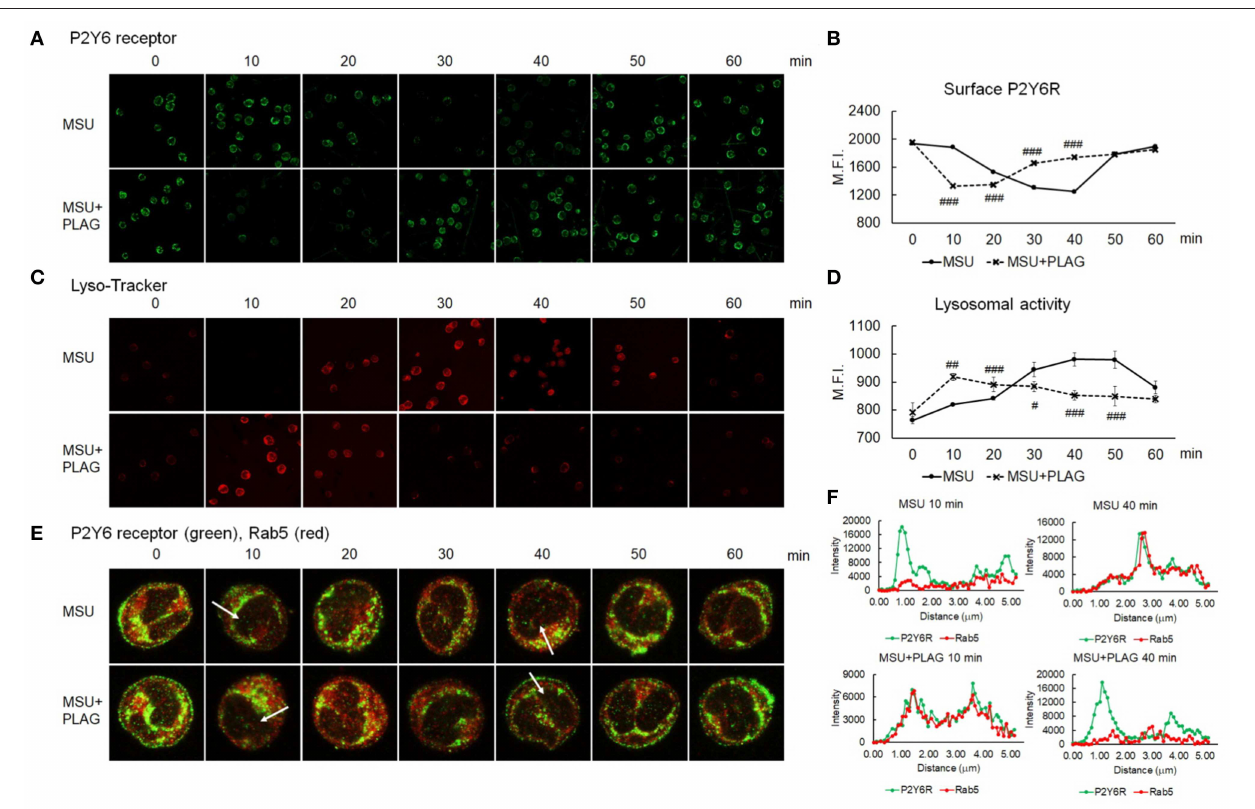
FIGURE 4 | Accelerated intracellular trafficking of MSU-loaded P2Y6 in PLAG-treated cells. (A) Analysis of cell surface P2Y6 receptor using confocal microscopy. THP-1 cells were pre-treated with PLAG (100 µ g/ml) for 1h and then were treated with MSU (200 µ g/ml). The cells were harvested and were fixed with 4% paraformaldehyde. The membrane-localized receptor was stained with anti-P2Y6 receptor antibody without permeabilization. (B) The result of (A) was also analyzed by flow cytometry. (C) Lysosomal activity was measured using lyso-ID and analyzed using confocal microscopy. (D) The result of (C) was also analyzed by flow cytometry. (E) Co-localization of P2Y6 receptor and Rab5 was examined using confocal microscopy. (F) Graphs show fluorescence intensity profiles calculated on the white arrows of the confocal images in (E) using ZEN program. Data are presented as mean ± SD. # p < 0.05, ## p < 0.01, ### p < 0.001, compared to the MSU-treated